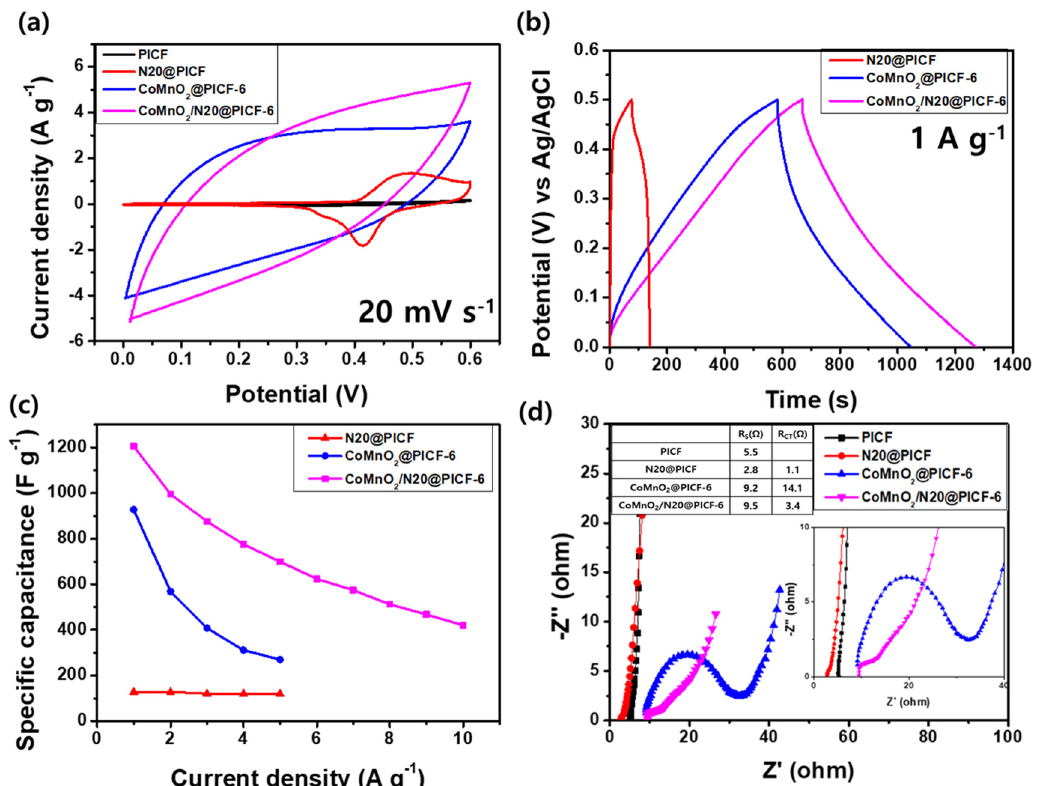
Figure 5. CV curves ( a ), GCD curves ( b ), specific capacitance vs. current density ( c ), Nyquist plot ( d ) of bare PICF, N20@PICF, CoMnO 2 @PICF-6 and CoMnO 2 /N20@PICF-6. Molecules 2020 , 25 , x FOR PEER REVIEW